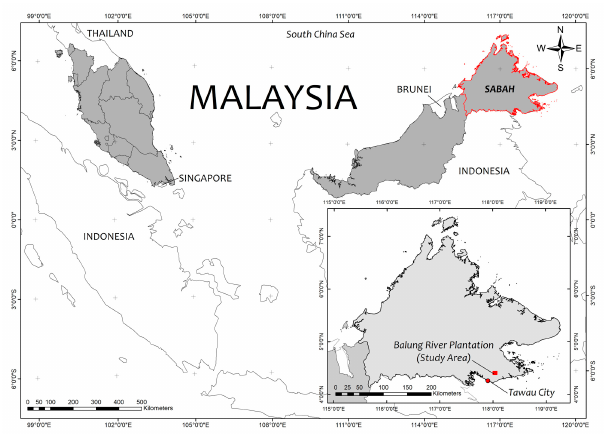
Figure 1. The Balung River Plantation area in Tawau City, Sabah, Malaysia.